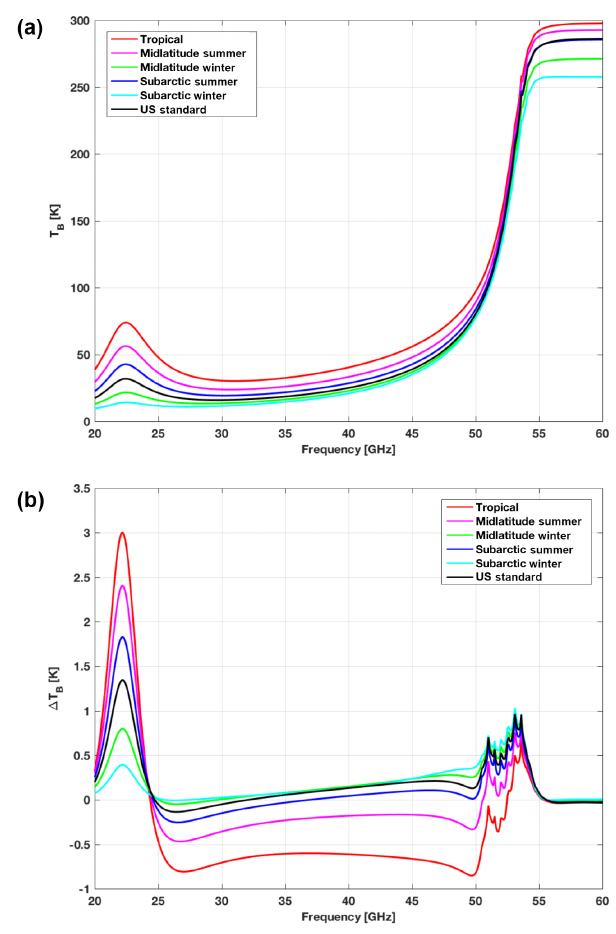
Figure 1. (a) Zenith downwelling T B computed using six reference atmosphere climatology conditions with the R17 model. (b) Differ- ence between T B computed with the current and reference versions (R17 minus R98) for the six atmosphere climatology conditions. Note the features at 22GHz, mainly attributable to the updated line width (Payne et al., 2008), at 25–50GHz due to the scaled con- tinuum (Turner et al., 2009), and at 50–55GHz related to revised coefficients for the 60GHz band (Tretyakov et al.,